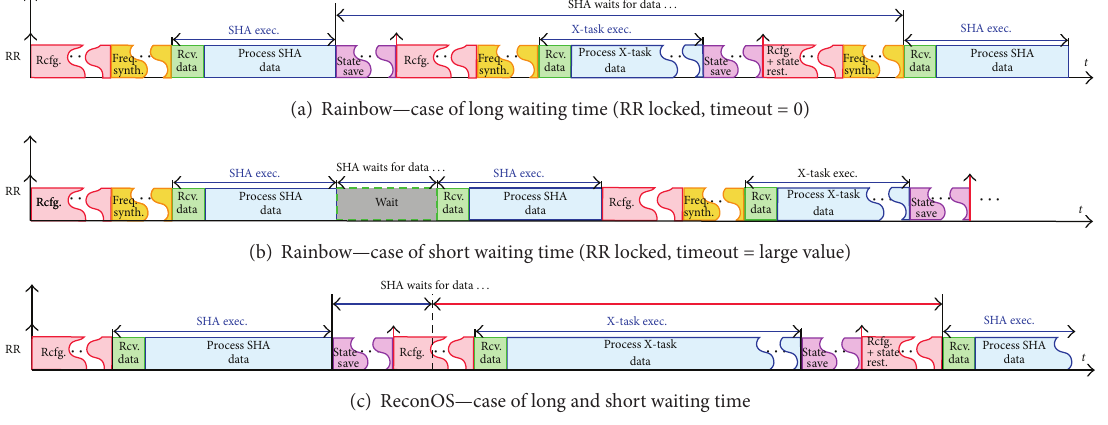
Figure 27: Rainbow versus ReconOS (blocked HW task case).